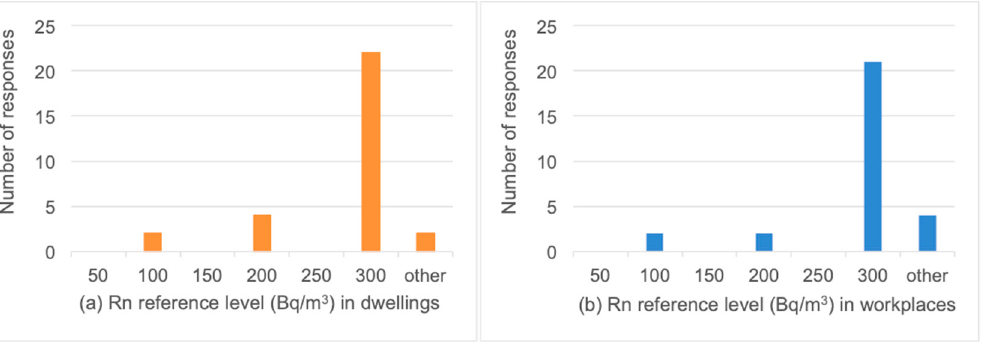
Figure 4. Reference levels for radon concentration in: ( a ) dwellings (orange), ( b ) workplaces (blue).